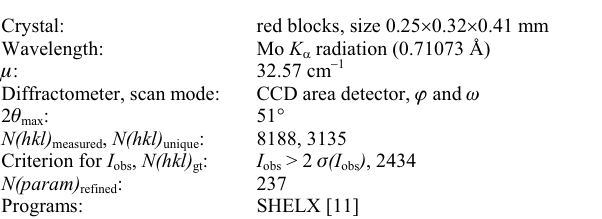
Table 1. Data collection and handling.